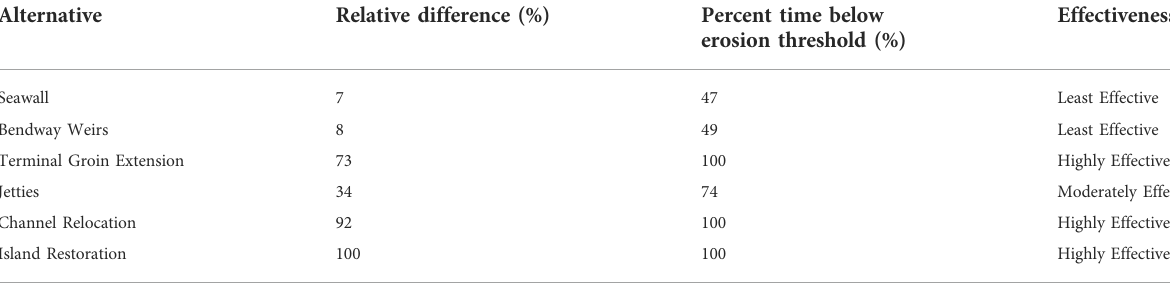
TABLE 4 Depth-averaged along-channel velocity comparison in the south fl ood channel. Alternative Relative difference (%) Percent time below Effectiveness erosion threshold (%) Seawall 7 47 Least Effective Bendway Weirs 8 49 Least Effective Terminal Groin Extension